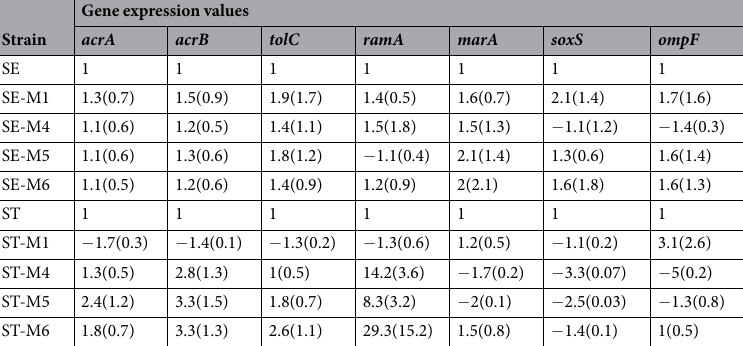
Table 2. Mean (SD) values of RT-PCR analysis obtained in six independent